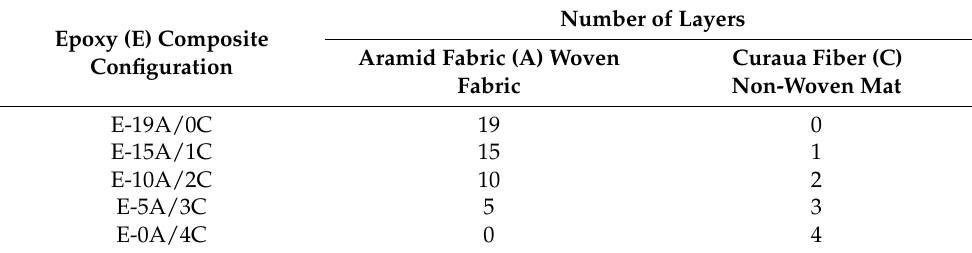
Table 2. Composites configuration based on the number of reinforcing layers.